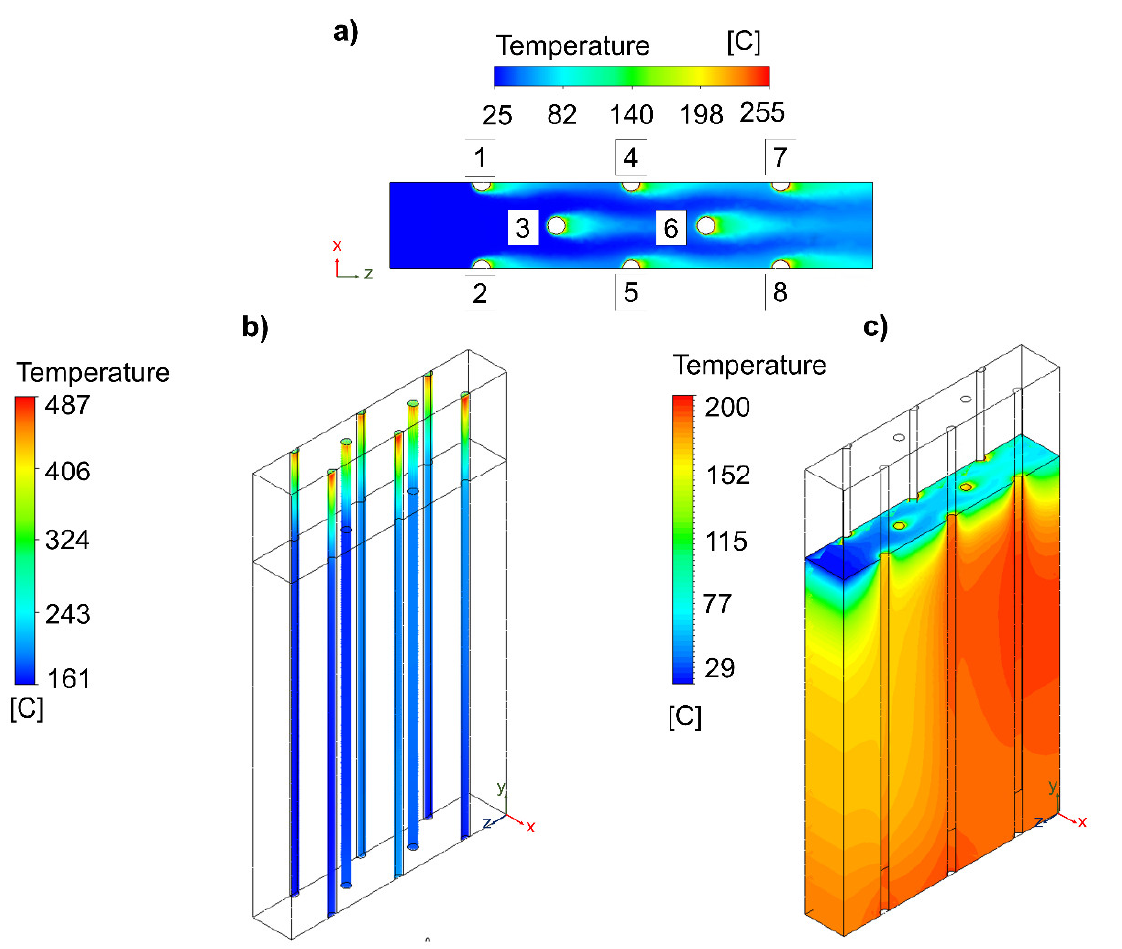
Figure 3. Influence of the increase in the number of reactive channels on the ( a ) air flow, ( b ) catalytic bed, and ( c ) insulating material. Specifications of the reactor design: number of reactive channels = 16; geometry configuration = hexagonal-shaped distribution; reactive channel length separation = 25 mm; free-reactive zone = 50 mm; insulation active zone = 200 mm.